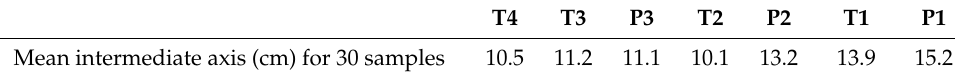
Mean intermediate axis (cm) for 30 samples